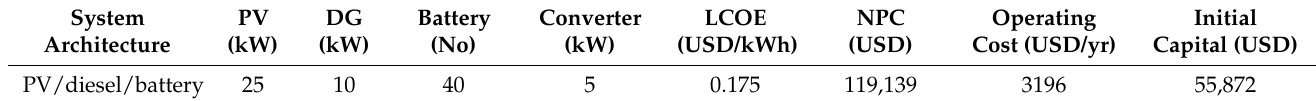
Table 4. Simulation result of optimal minigrid system, architecture, and cost.